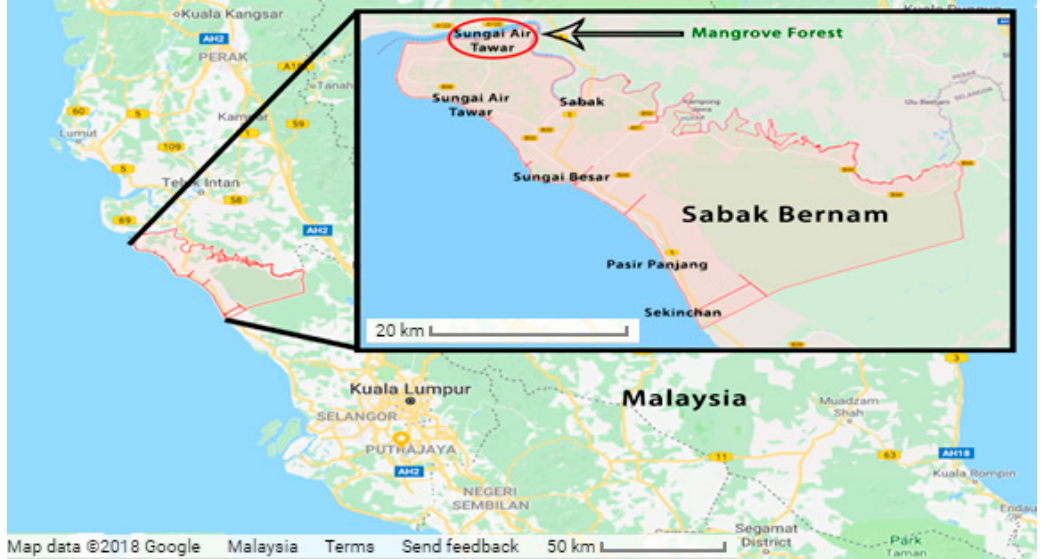
Figure 1. Google map illustrating the location of the target mangrove forest site in Sabak Bernam,